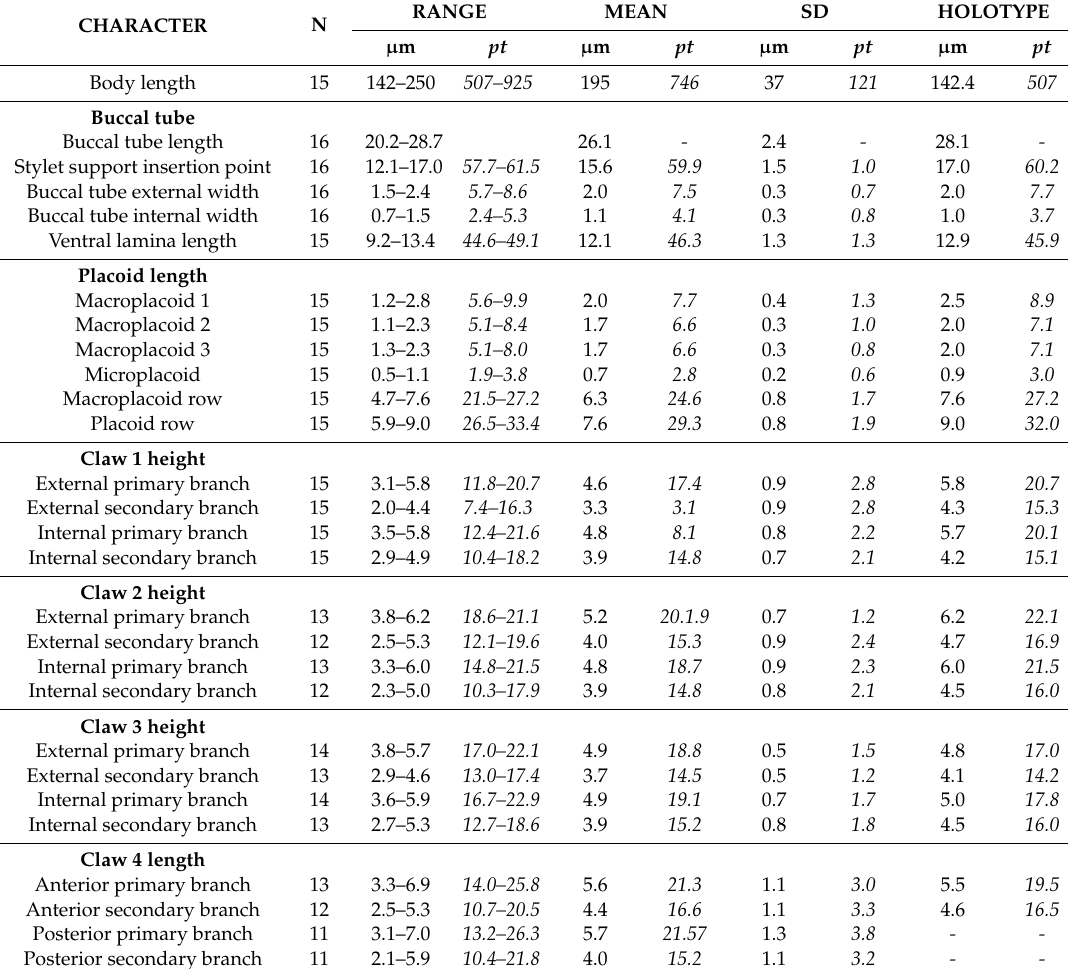
Table 2. Measurements and pt values of selected morphological structures of Minibiotus citlalium sp. nov. mounted in polivinil lactofenol medium. The individuals measured correspond to serial type (N- number of specimens / structures measured; RANGE refers to the smallest and the largest structure among all measured specimens; and SD—standard